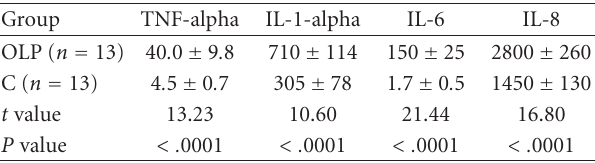
Table 2: The Levels of four cytokines in TT from subjests (pg/mL). Group